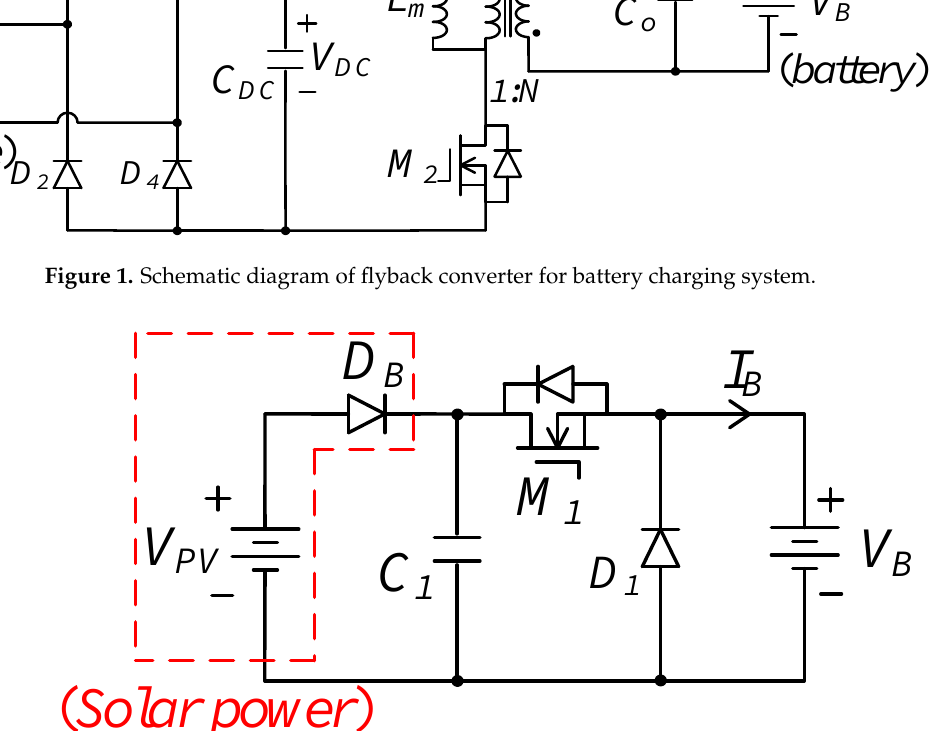
Figure 2. Schematic diagram of buck converter for battery charging system.